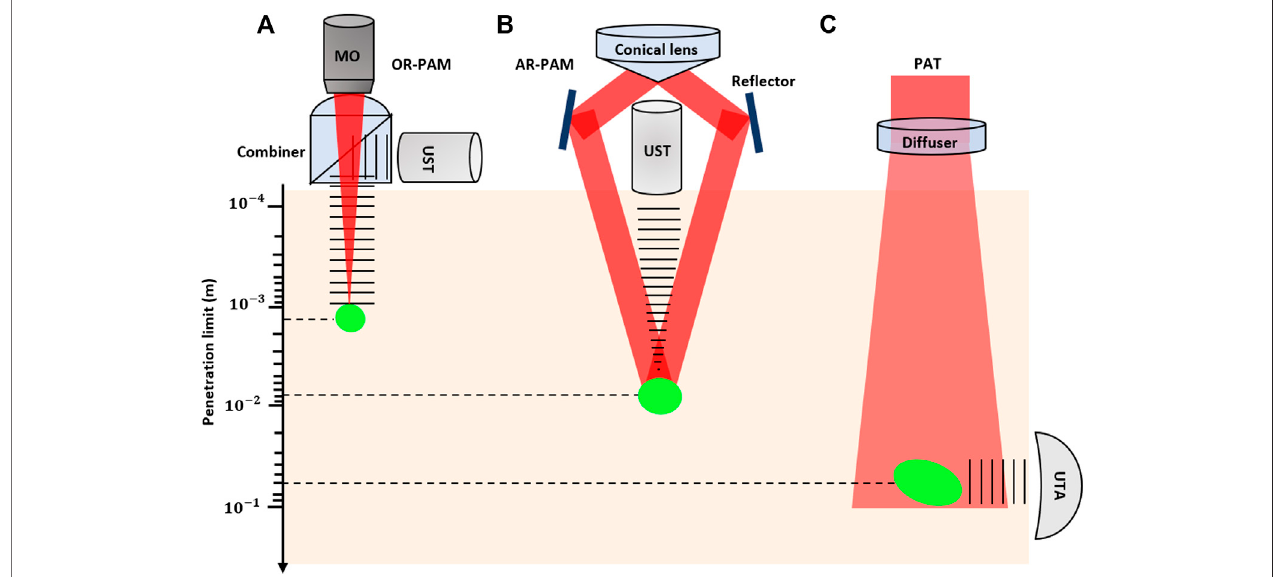
FIGURE 1 | Signal generation and detection in different implementations of PAI and penetration limits in scattering tissue. (A) Re fl ection-mode OR-PAM system with an optical – acoustic combiner that transmits light but re fl ects sound; (B) AR-PAM system where the laser light is poorly focused; (C) PAT system with ultrasonic transducer array (UTA). The laser beam is expanded and homogenized by a diffuser to provide wide fi eld